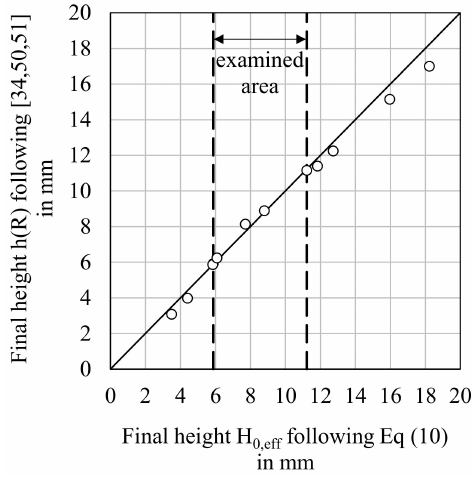
Figure A2. Comparison of the final height of the cement paste following Equation (10) and the final height of the cement paste h(R) after a mini slump flow following [50,51] used in [34].